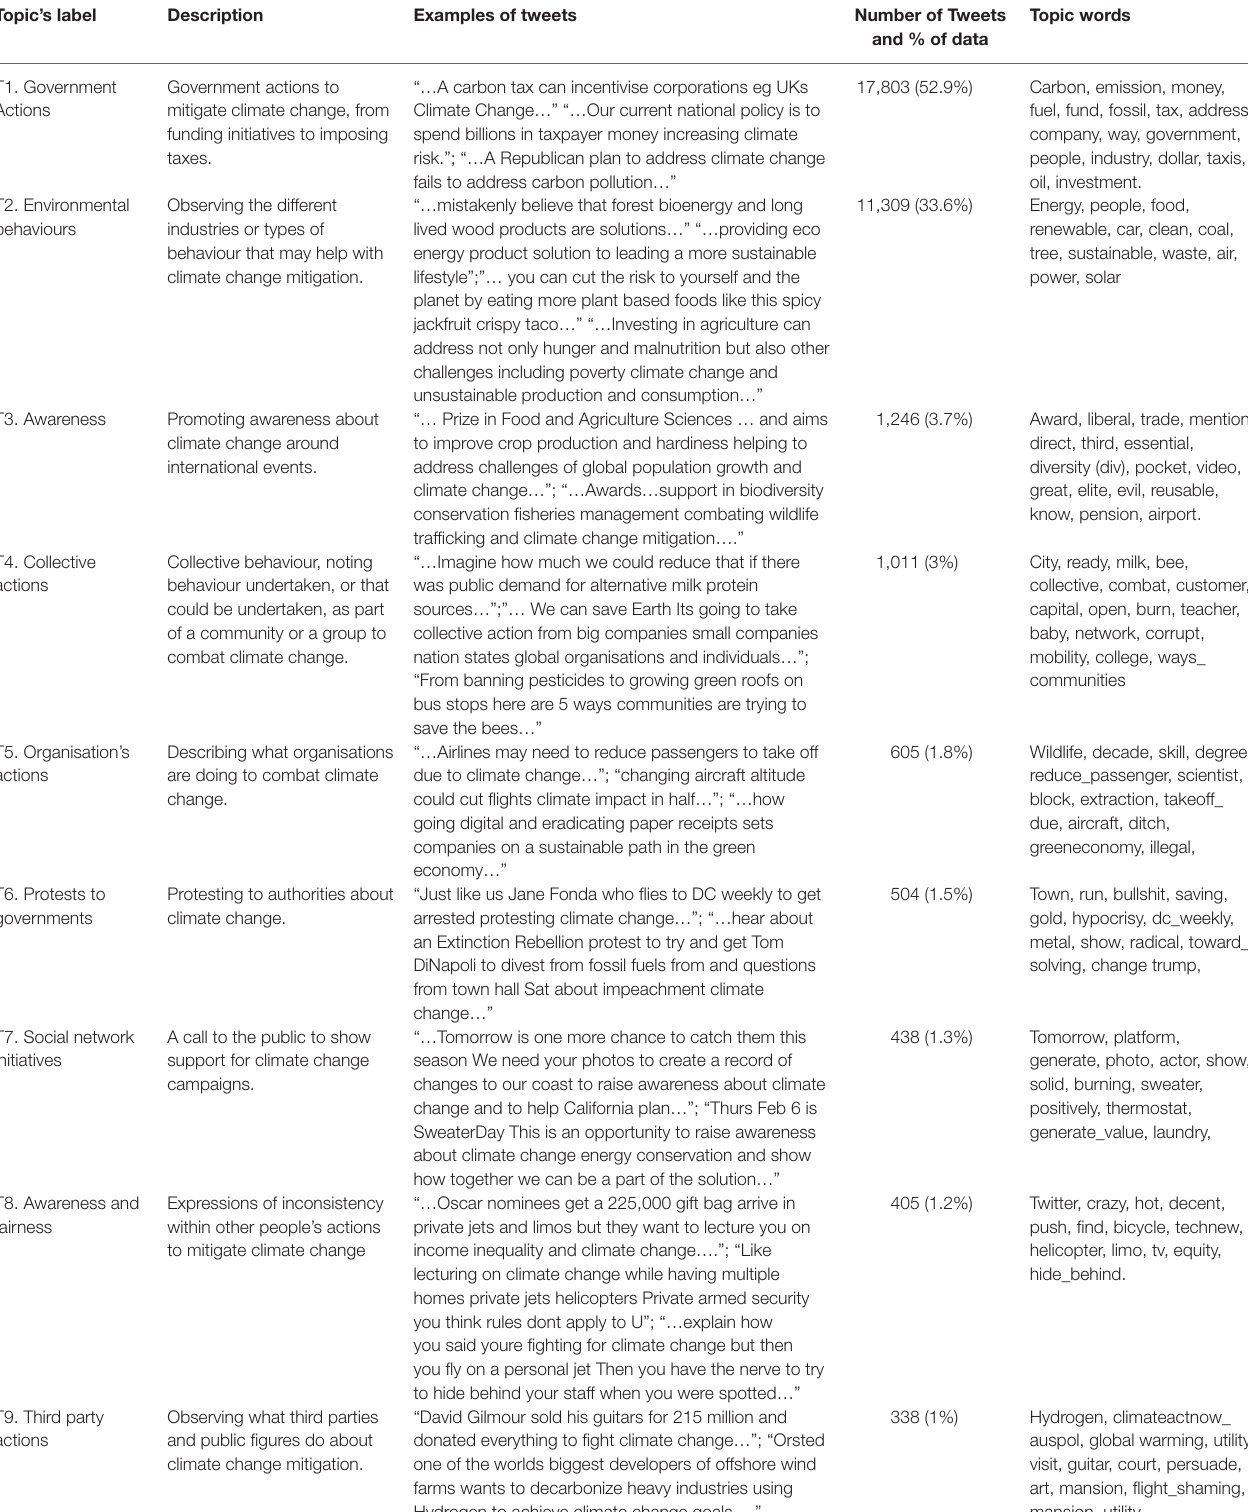
TABLE 5 | Time 1. Labelled topics and topic words within tweets from February 2020. Topic’s label Description Examples of tweets Number of Tweets